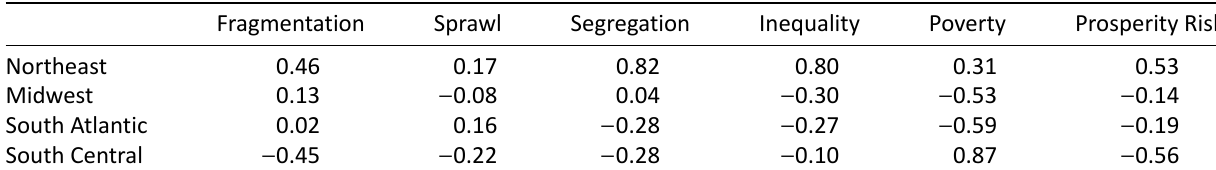
Table 1. Z-scores for PRIMED characteristics by census grouping.